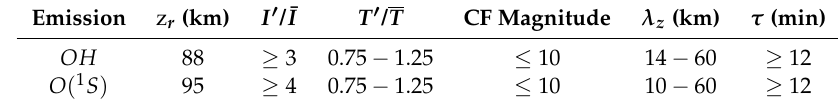
Table 4. Criteria used for filtering the dataset for the OH Meinel band and O ( 1 S ) emission line.